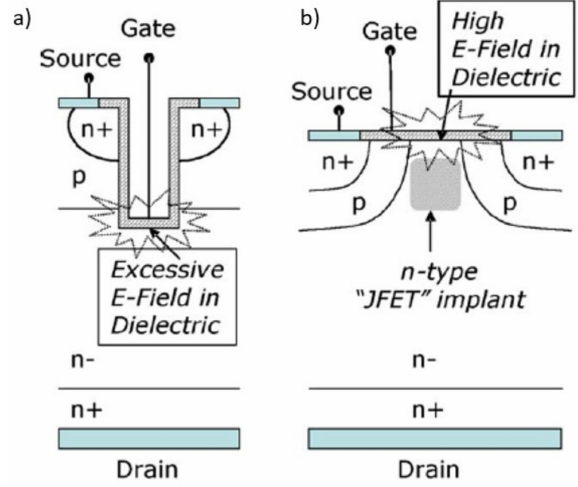
Figure 13. High electric field stress of ( a ) UMOSFETs and ( b ) DMOSFETs [195].